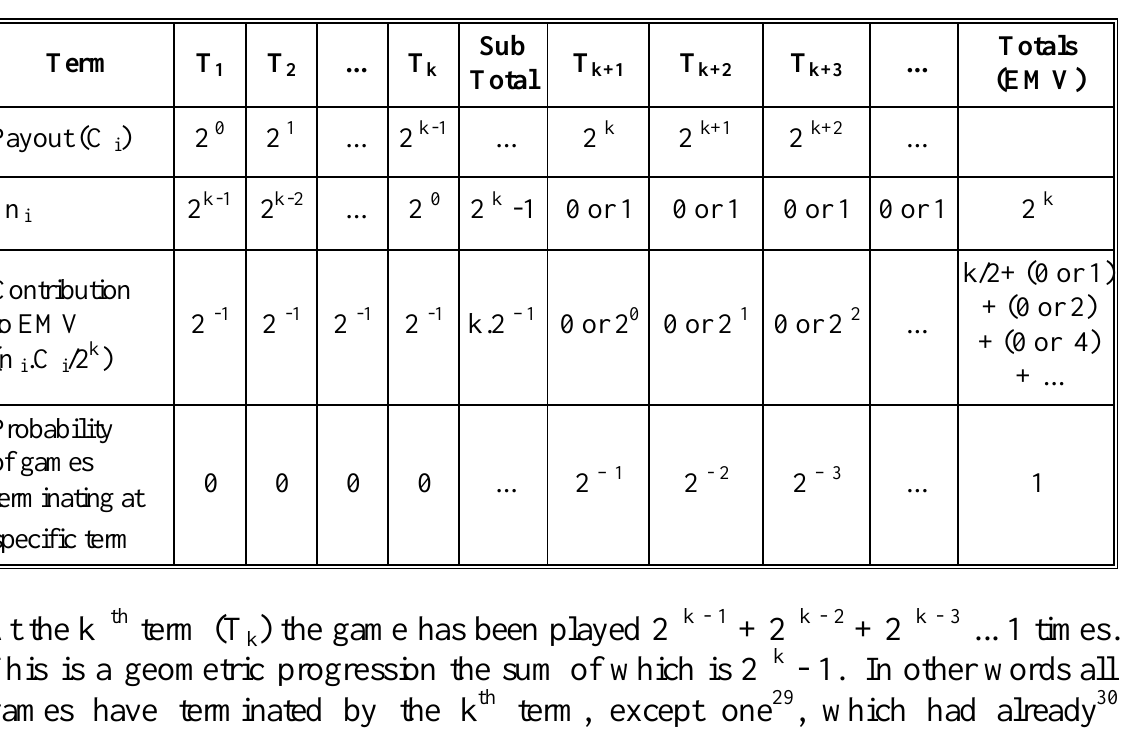
The EMV of the St Petersburg game played 2 k